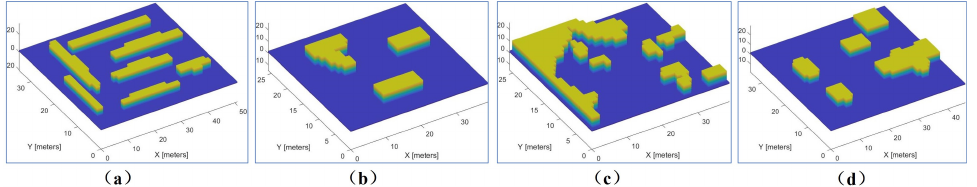
Figure 13. Four point-cloud maps where CDM and DCRC were tested. ( a ) Multi-cell (34 m × 50 m × 10 m); ( b ) Farm (25 × 38 m × 10 m); ( c ) Rural Quebec (25 m × 38 m × 10 m); ( d ) Cave (34 m × 45 m × 10